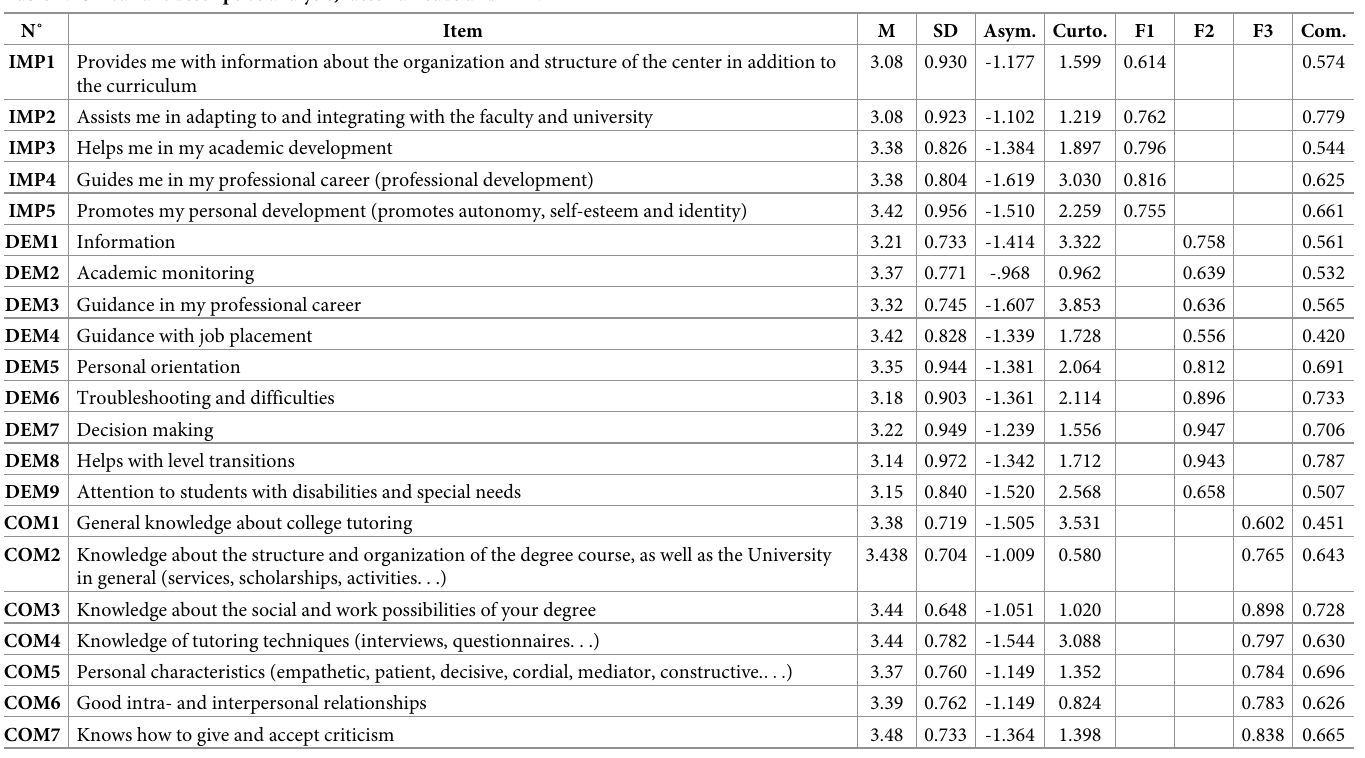
Table 1. Univariant descriptive analysis, factorial loads and